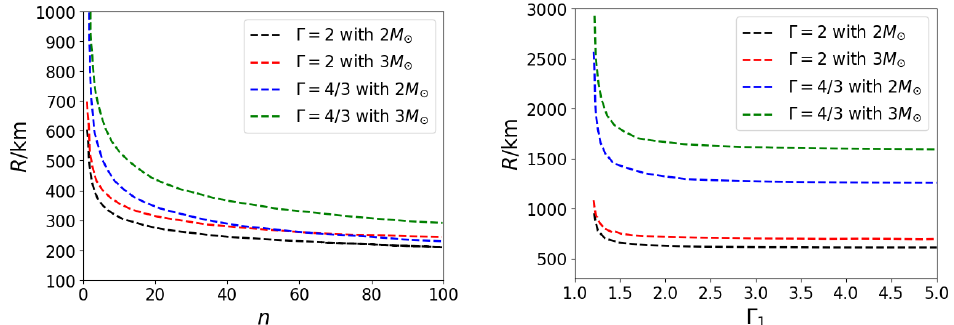
Figure 2. Left panel: Variation of radius with n for the conserved flux model with various Γ and total masses. Right panel: Variation of radius with Γ 1 for the power-law field model with various Γ and total masses. In each case, Γ = 4/3 corresponds to B = 10 14 G, and Γ = 2 corresponds to B = 10 16 G, with B being the average magnetic field. Parameter sets from top to bottom mentioned in the figures correspond to the lines sequentially from bottom to top in the low n and Γ 1 regimes. See